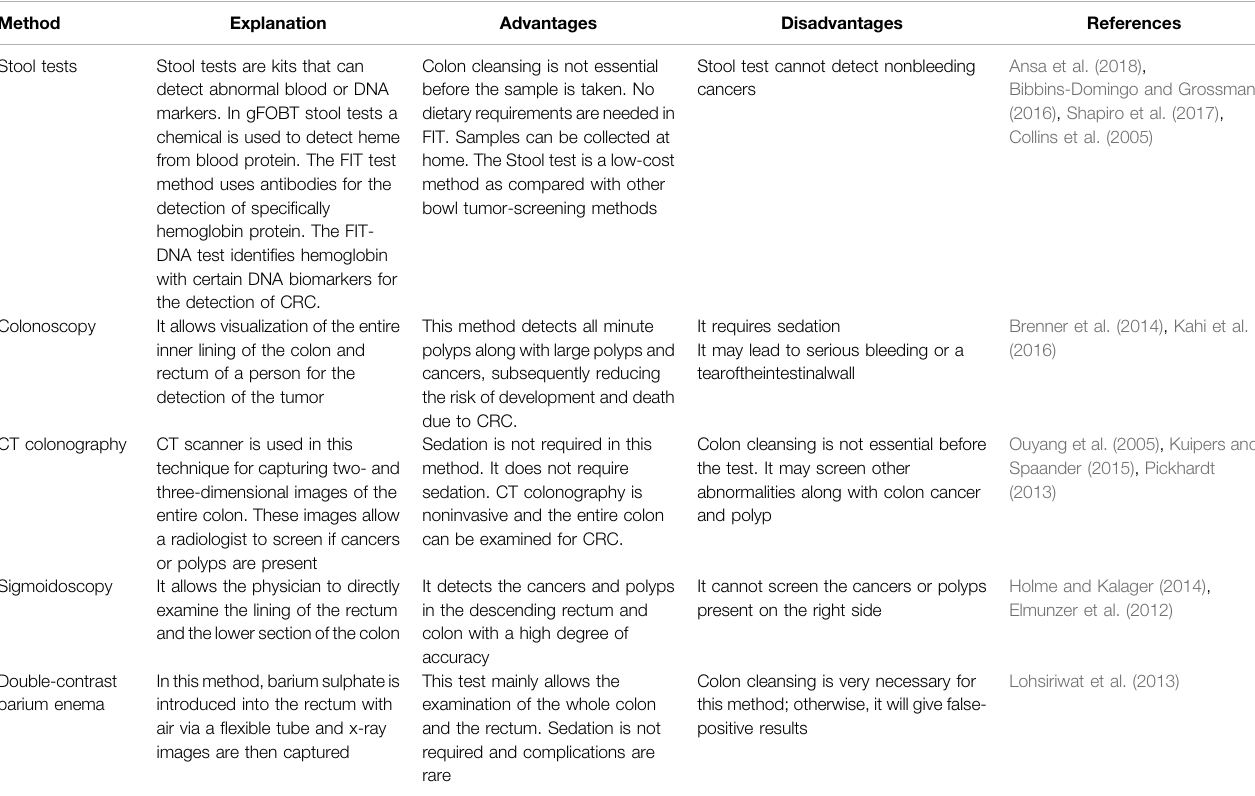
TABLE 1 | Different methods for CRC